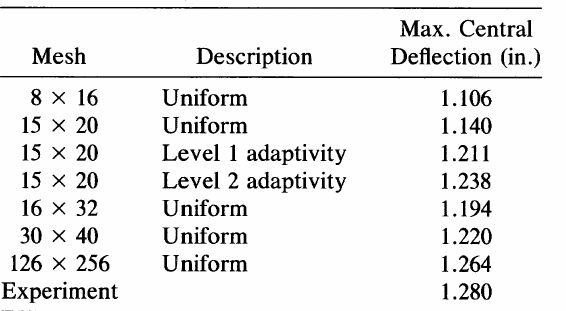
Table III. Results for Cylindrical Panel (With and Without Adaptivity) Mesh Description Deflection